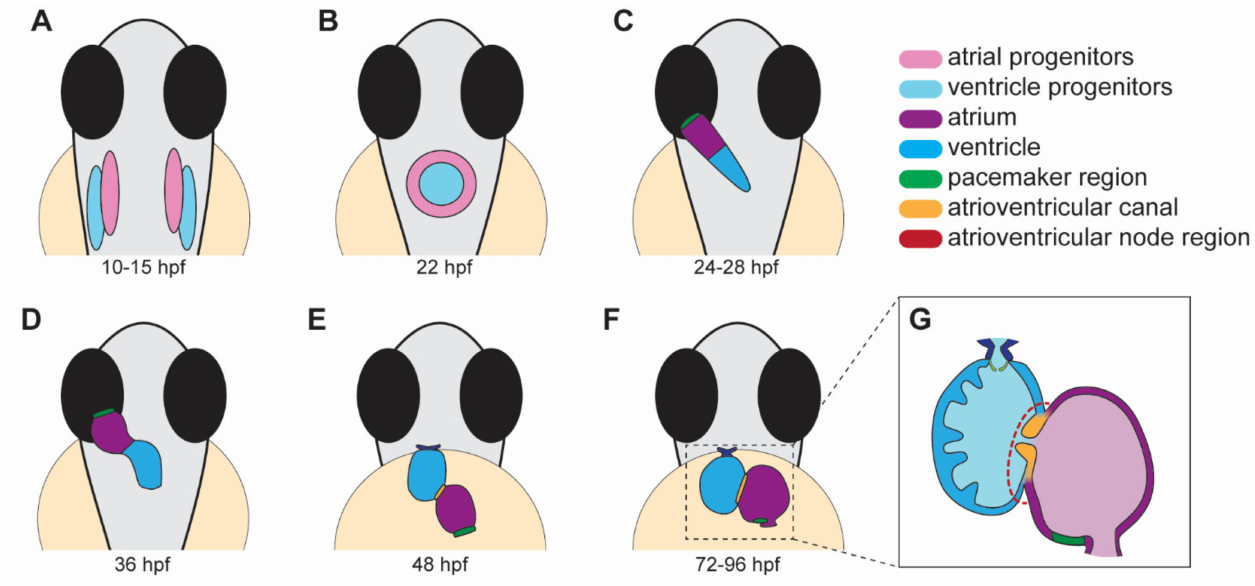
Figure 1. Stages of heart development in zebrafish from 10 to 96 h post-fertilization (hpf). ( A ) Atrial and ventricular cardiac progenitors are located in the anterior lateral plate mesoderm by ~15 hpf. ( B ) The cardiac disc is visible by 22 hpf as cardiac progenitors surround endocardial cells at the midline. ( C ) At 24 hpf, the linear heart tube forms and jogs to the left in preparation for heart looping. ( D ) At 36 hpf, the heart tube undergoes rightward looping. The AV canal (orange) begins to develop between the cardiac chambers. ( E ) At 48 hpf, the cardiac chambers begin to balloon and expand outwards. The bulbus arteriosus (dark blue) and AV canal (orange) continue to develop and mature. ( F ) From 72 to 96 hpf, the cardiac chambers expand and align beside each other. ( G ) A cross-section of a 96 hpf heart showing the trabeculae, the finger-like muscular projections on the inner wall of the ventricle, and endocardial leaflets (orange) of the AV canal. ( A – D ) dorsal views; ( E – G ) ventral